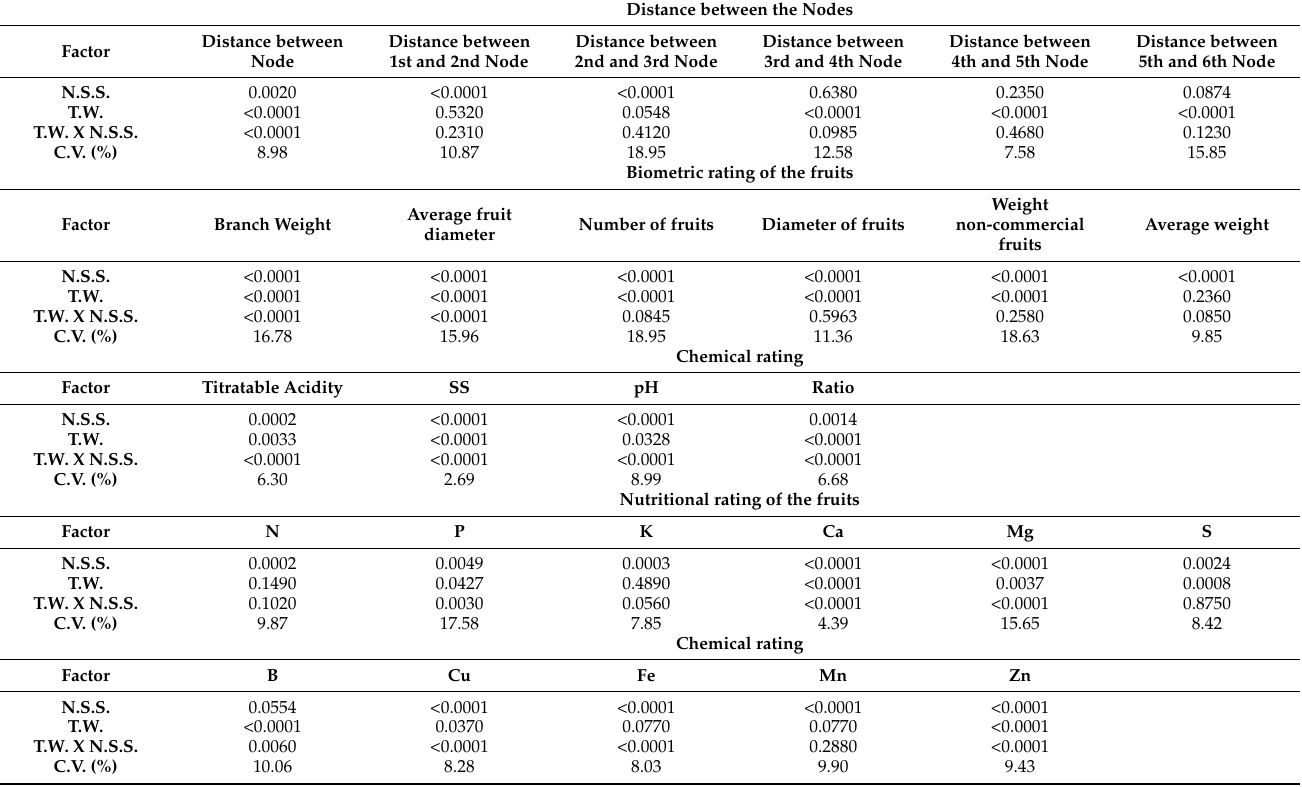
Table 2. p -values are associated with the factors of water types, nutrient solution strengths, the distance between nodes, and biometric and chemical evaluations of the fruits and